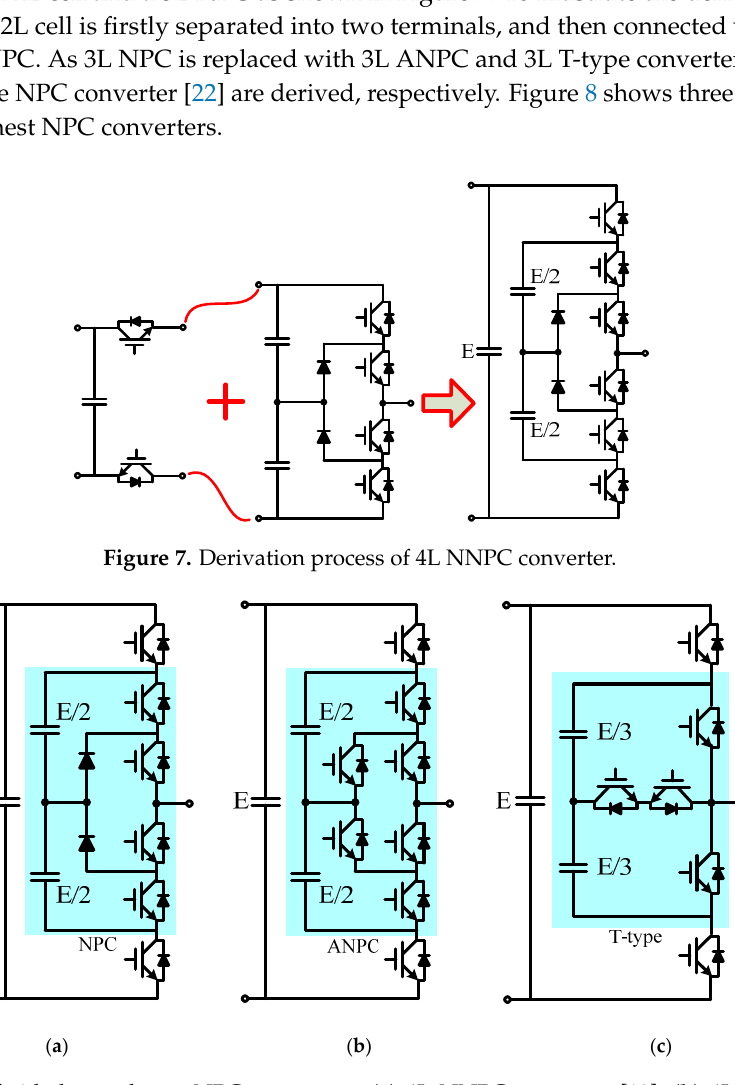
Figure 6. Derivation process of hybrid multilevel converters. ( a ) 3L T ‐ type cell [18], ( b ) 5L SM converter, ( c ) 4L π‐ type converter [31], ( d ) general topology of SM converter, ( e ) general topology of π‐ type converter.